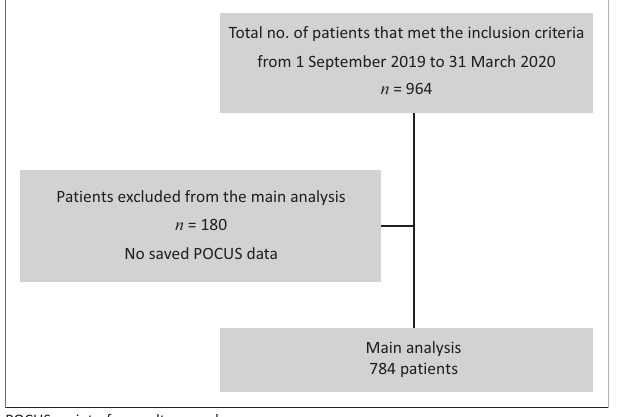
FIGURE 1: Flowchart of the sampling strategy.